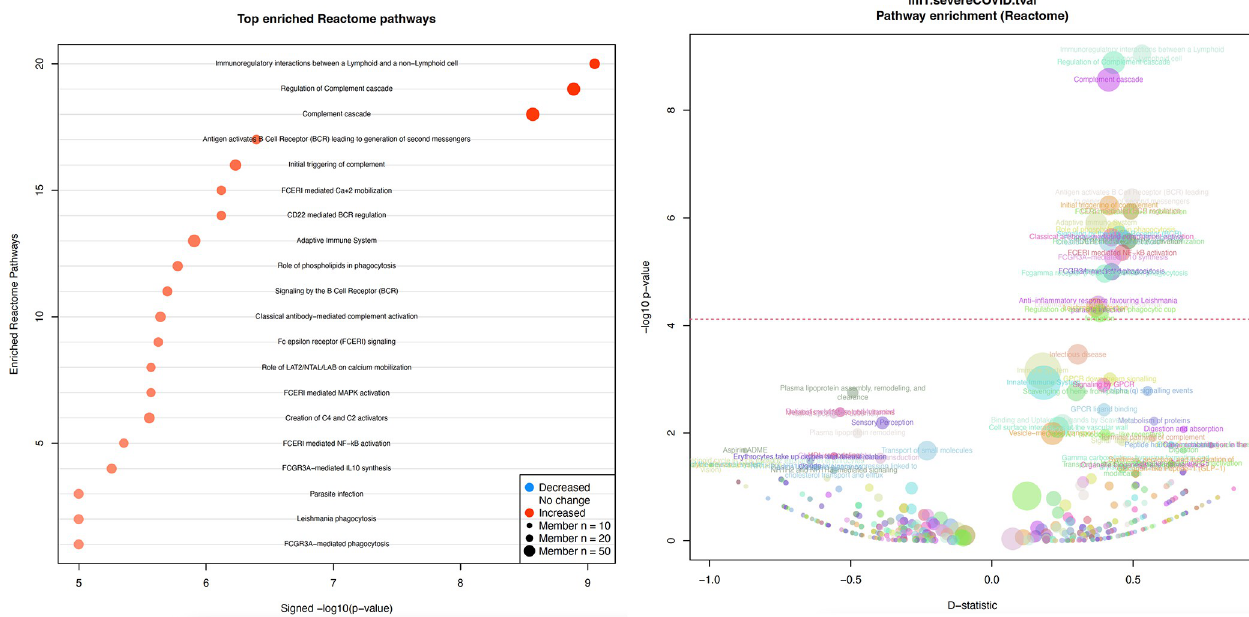
Fig 2. a. Top enriched Reactome pathways. b. Severe COVID-19 pathway